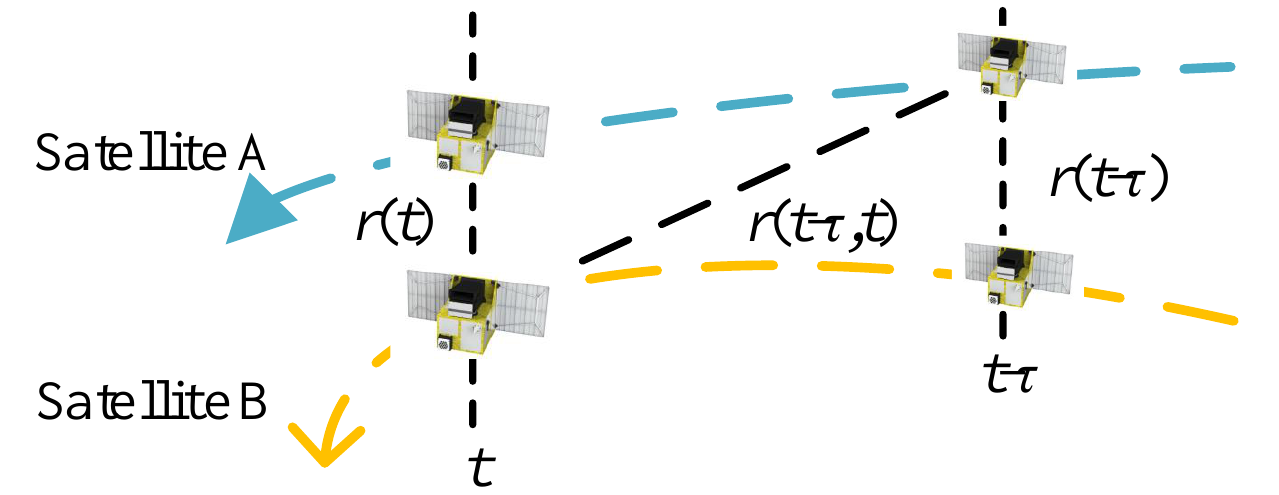
Figure 3. The geometric range between two satellites. In fact, the direction of v A34 is opposite to that of v B12 and v B56 , and for a short time v AB35 and v AB13 can be considered to be equal. Therefore, the combinations of v A34 + v B12 , v A34 + v B56 and v AB35 − v AB13 enable ADS-TWR to reduce the motion error to a certain extent. Equations (11) and (12) show that, compared with the ranging error, the time difference measurement error caused by satellite motion adds one error item, which is related to the transmission times and the satellites’ absolute speed.